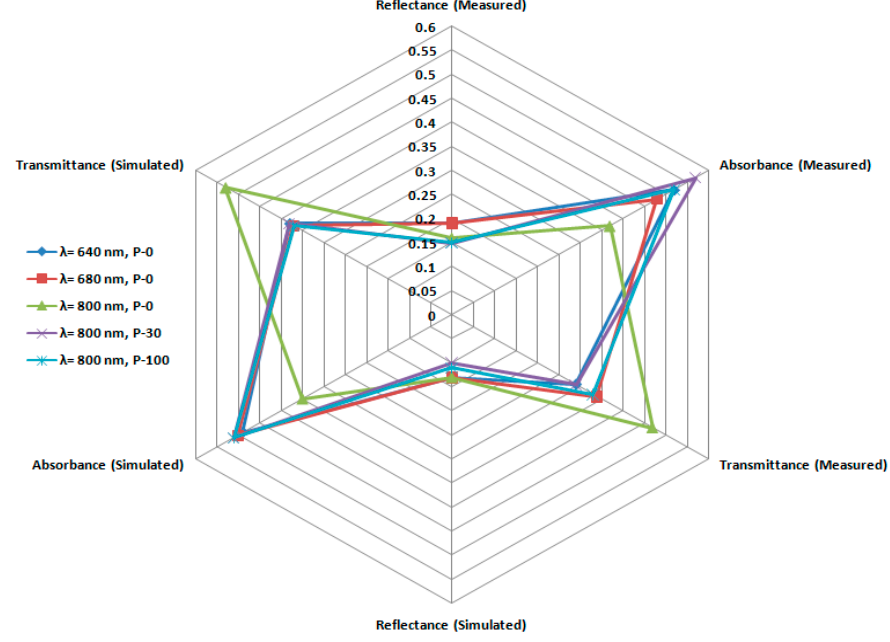
Figure 5. Radar Plot for representing the theoretical and experimental data validation.